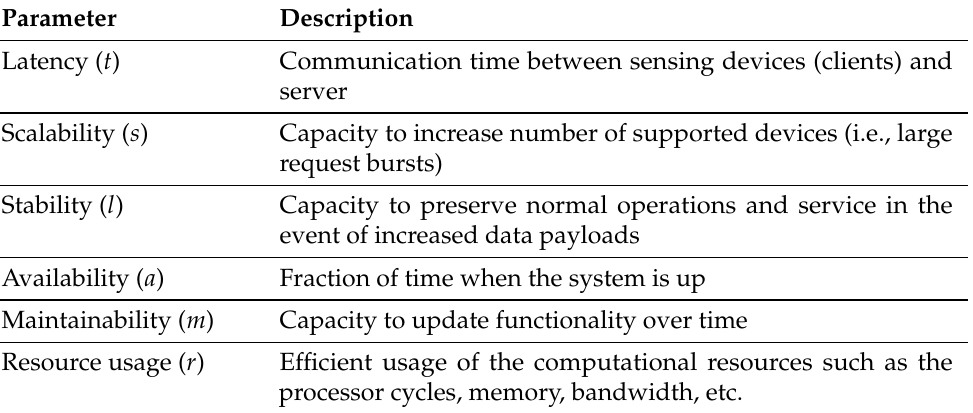
Figure 2. Evaluation process: phases and activities. Table 1. Potential evaluation parameters—some examples. Some parameters can be expanded into a subset, e.g., r into c (processor time),